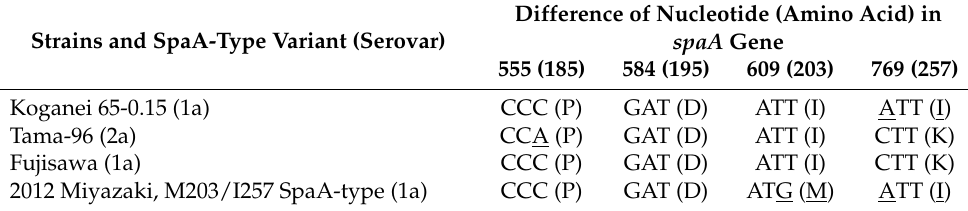
Difference of Nucleotide (Amino Acid) in spaA Gene 555 (185) 584 (195) 609 (203) 769 (257)